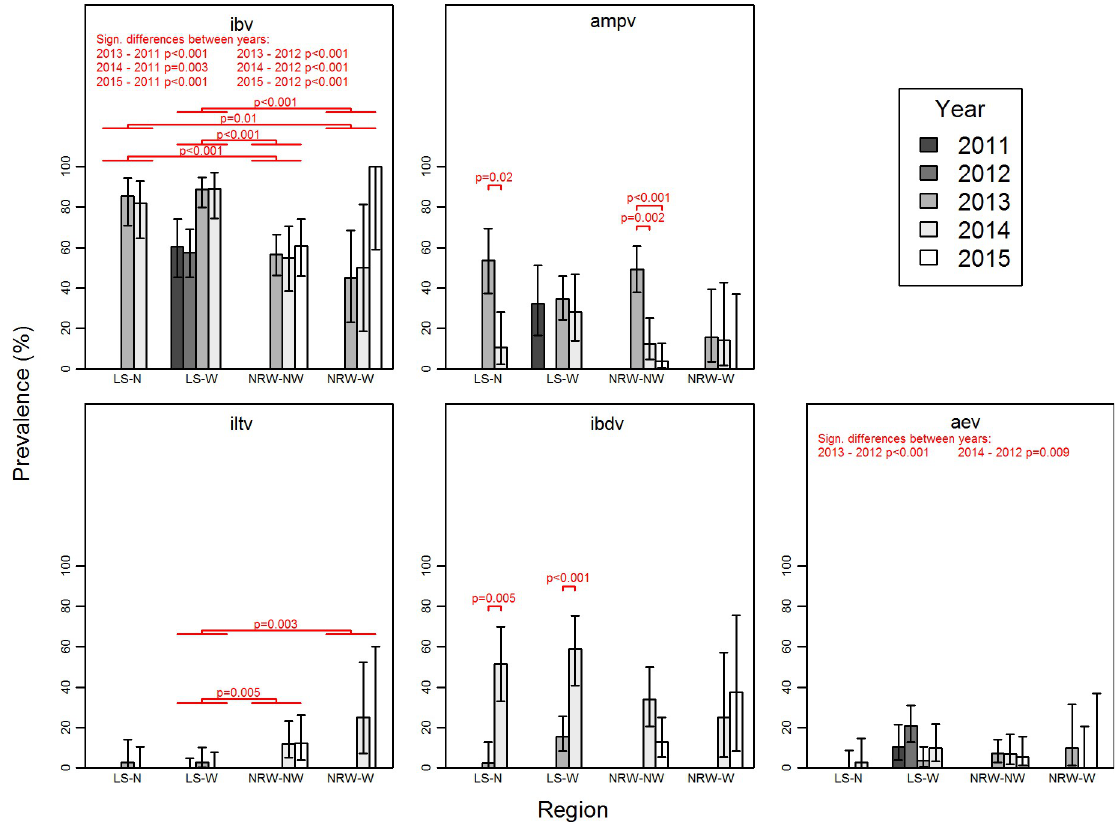
Fig 2. Prevalence of antibodies against the five viral pathogens for different regions and years. Results from the paired post-hoc comparisons with Bonferroni-Holm correction are given in red.